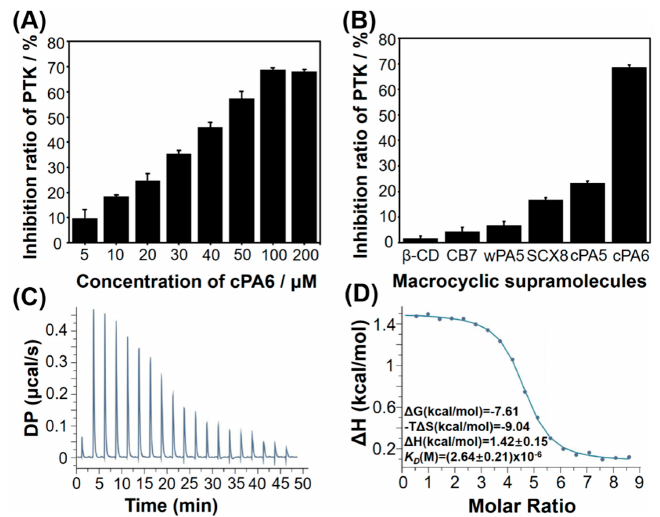
Figure 2. ( A ) In vitro inhibition of Tyr phosphorylation by various concentrations of cPA6. ( B ) The inhibition of Tyr phosphorylation by different macrocyclic supramolecules. Each supramolecule of cPA6 (100 μ M), cationic pillar[5]arene (cPA5) (400 μ M), sulfonated calix[8]arene (SCX8) (400 μ M), water-soluble carboxylated pillar[5]arene (wPA5) (400 μ M), cucurbit[7]uril (CB7) (400 μ M), or β -cyclodextrin ( β -CD) (400 μ M) was dissolved in PBS (pH 7.2) and added to the wells containing a polyEY (pEY) substrate at 25 °C for 1 h before the addition of Protein tyrosine kinase (PTK) and adenosine triphosphate (ATP). Data are presented as the mean ±SD ( n = 3). ( C ) and ( D ) Isothermal titration calorimetry (ITC) assay of cPA6 with pEY in PBS (pH 7.2) at 25 °C. The data indicate that the K D is 2.64 × 10 − 6 M for interaction between cPA6 and pEY. ( C ) Raw ITC data for 19 sequential injections (10 µ L per injection) of a pEY solution (2.00 mM) into a cPA5 solution (0.045 mM). ( D ) Net reaction heat obtained from the integration of the calorimetric